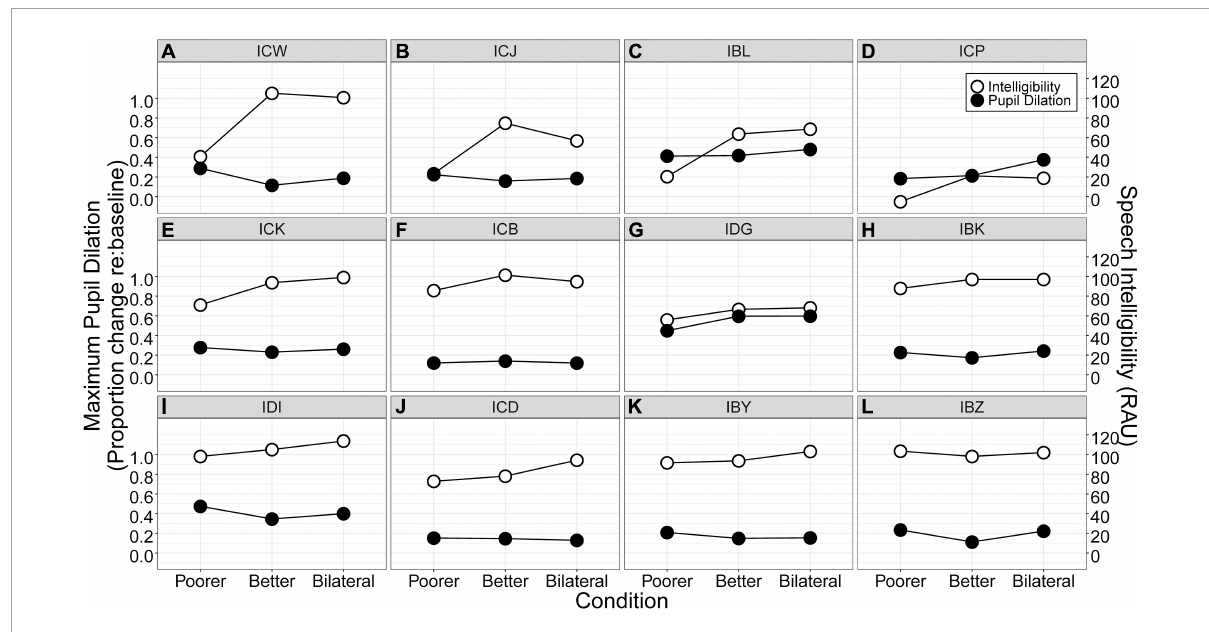
FIGURE6 Speech intelligibility (RAU; open circles) and maximum proportional change in pupil dilation (closed circles) for each participant. Participants (A–L) are ordered from largest to smallest interaural speech